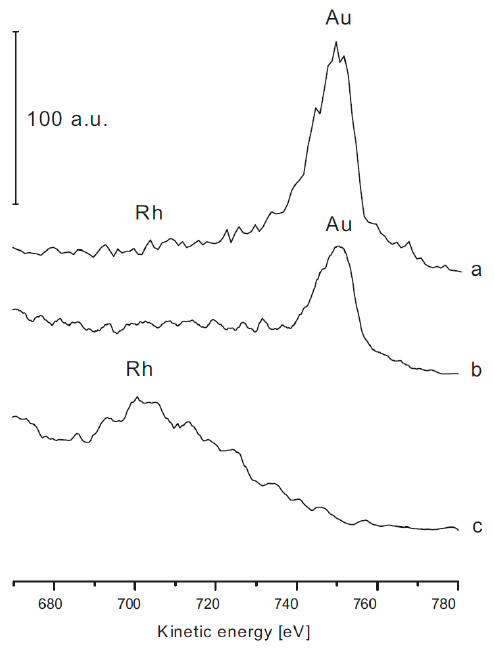
Figure 7. Low-energy ion scattering spectra (LEIS) of 1% Au / TiONW (b), 1% Rh / TiONW (c), 0.5% Au + 0.5% Rh / TiONW (a). Reproduced from [89].